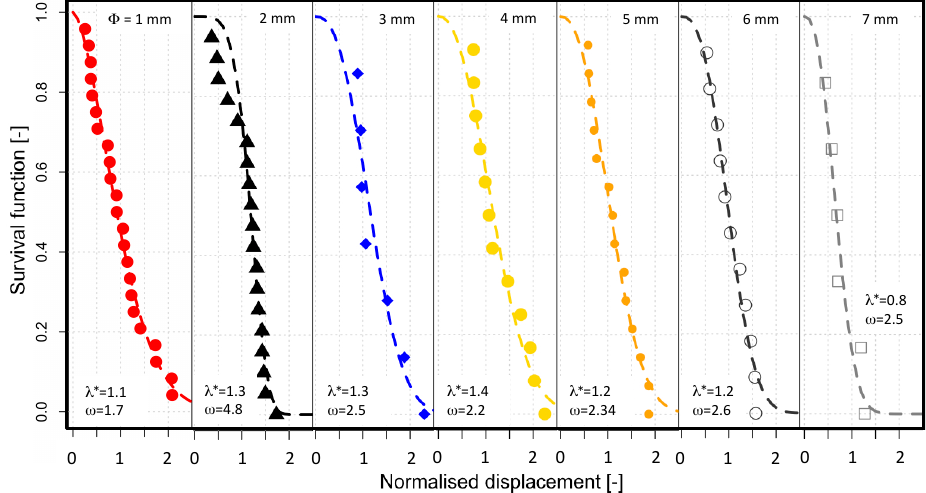
Fig. 8. Survival function calculated for the tensile tests data of each single root diameter class (from 1 to 7mm).